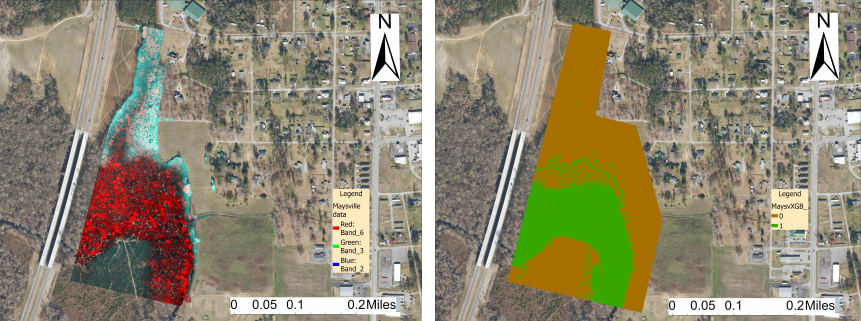
Figure 6. Visual representation of the spectral bands of the Maysville site ( left ) and the XGBM classification model for the Maysville site ( right ).